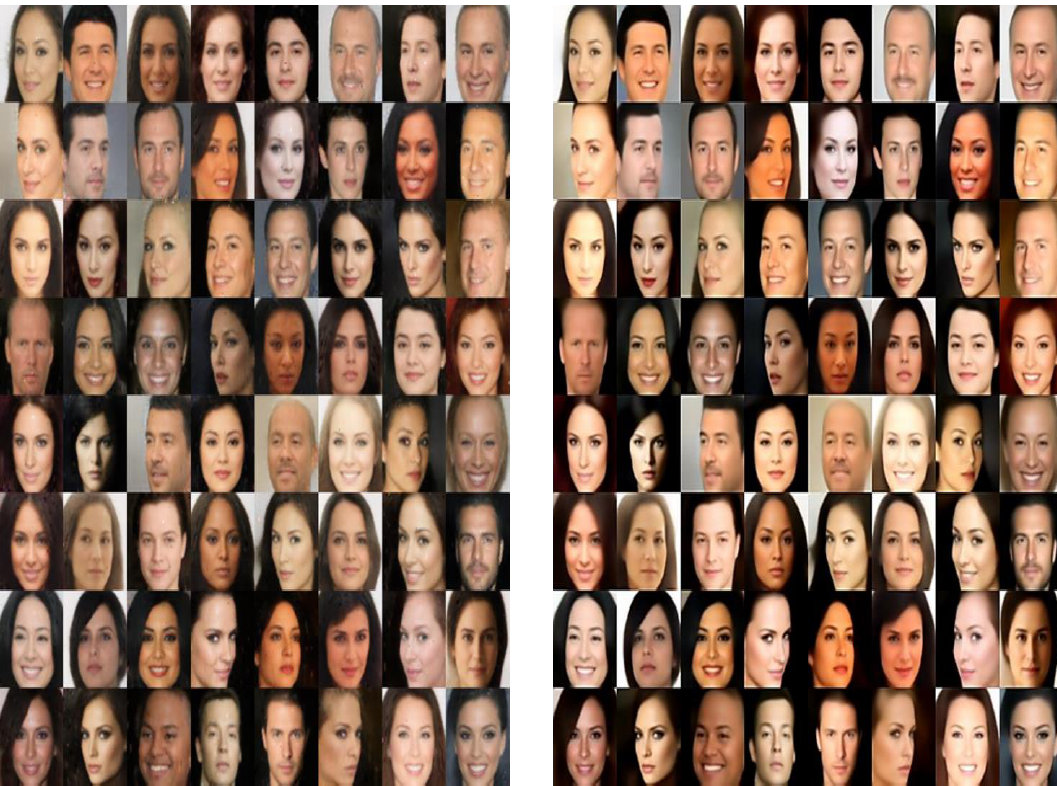
Figure 15. Representative images of 𝐺 ( left ) and 𝑉𝐴𝐸 ( right ) in the proposed model (L1 loss).